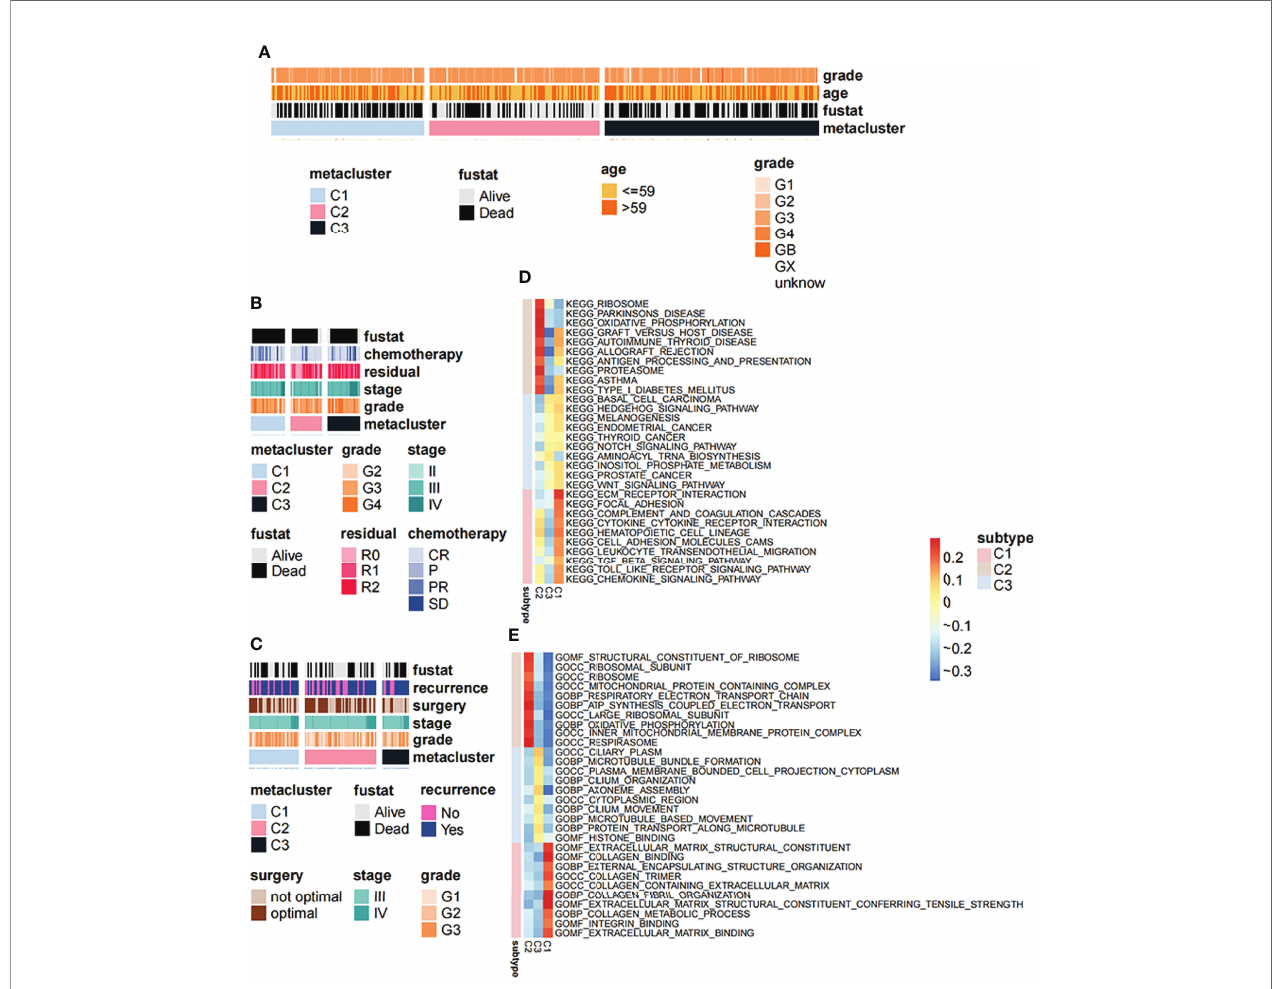
FIGURE 4 | Correlation between clinical symptoms and signaling pathways with OV subtypes. (A) Correlation of OV subtypes with age, pathological stage, grade and survival of OV patients in TCGA dataset. (B) Correlation of OV subtypes with age, pathological stage, grade and survival of OV patients in GSE63885 dataset. (C) Correlation of OV subtypes with age, pathological stage, grade, tumor recurrence and survival of OV patient in GSE17260 dataset. (D) Differences in gene ontology enrichment functional terms among the three subtypes. (E) Differences in KEGG enrichment functional pathways among the three